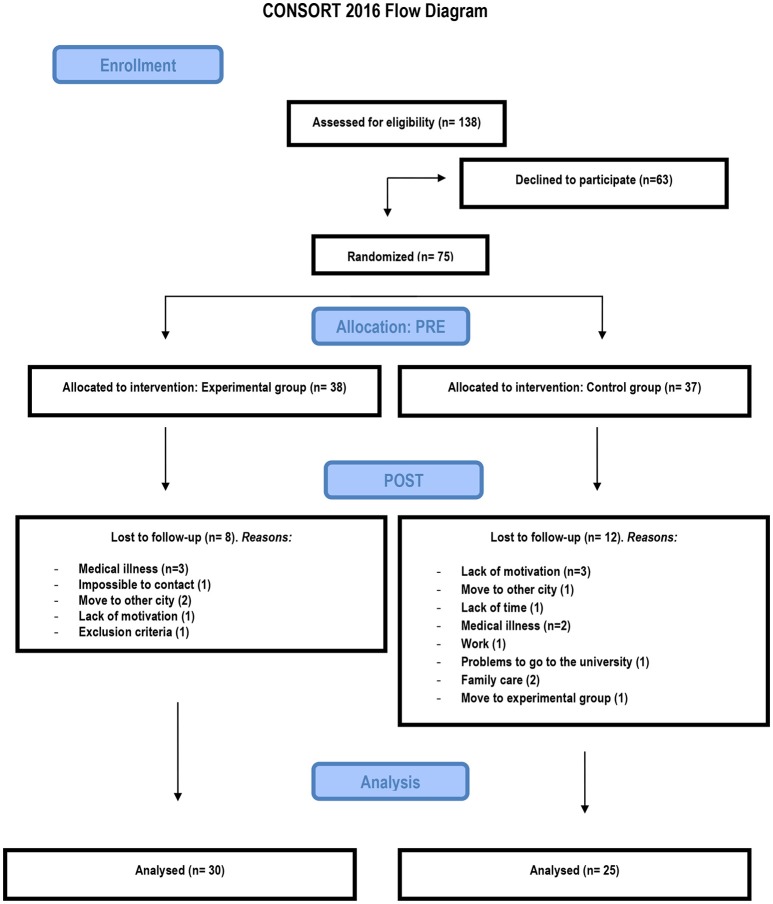
Consort flowchart.